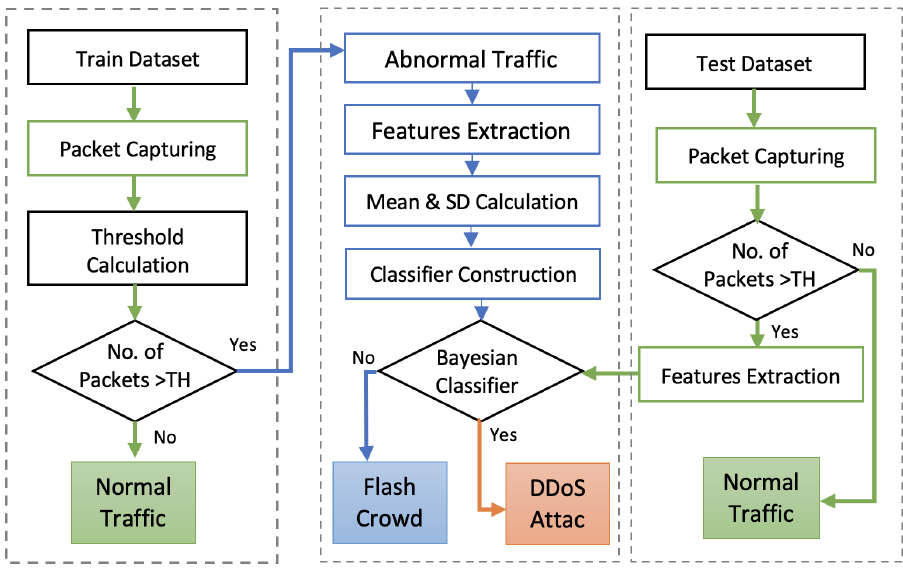
Figure 2. The overall structure of the proposed